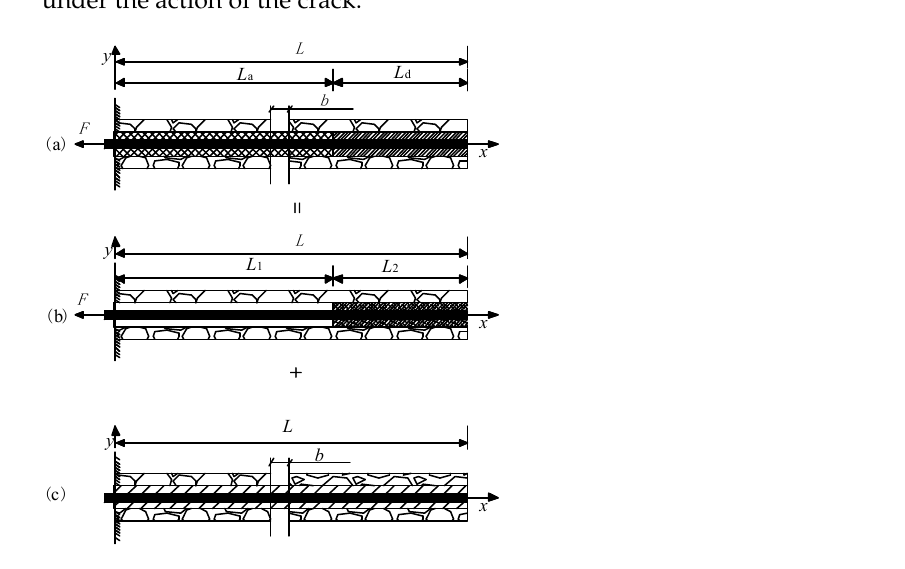
Figure 1. Basic constitution of the full-grouted prestressed bolt.